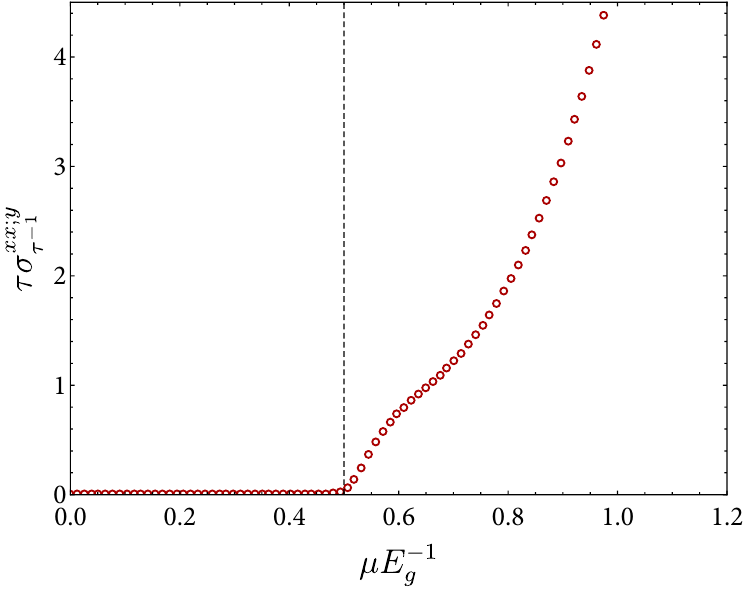
Figure 5: Transverse conductivity at order τ − 1 . Dashed lines indicate the onset of a band gap. The conductivity rises monotonically whenever | µ | > E exhibits particle hole symmetry, σ xx ; y